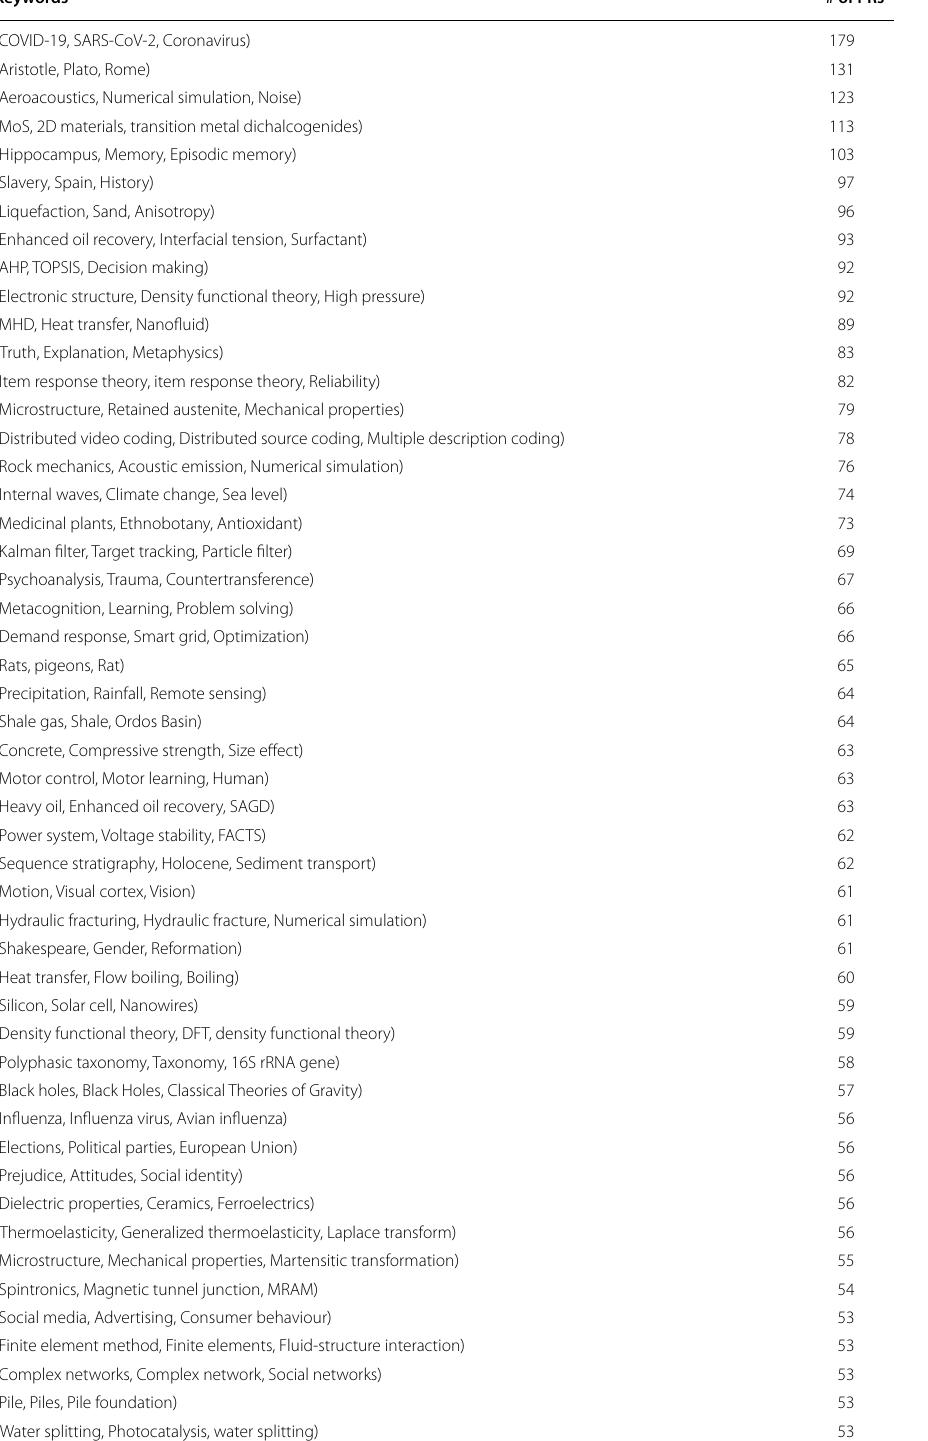
Table 13 Most frequent category including PR (Category labelled by 2020)